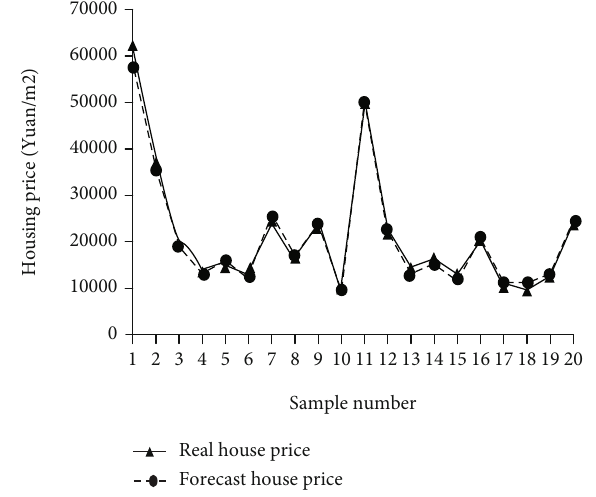
Figure 6: The error between the predicted house price and the actual value of the